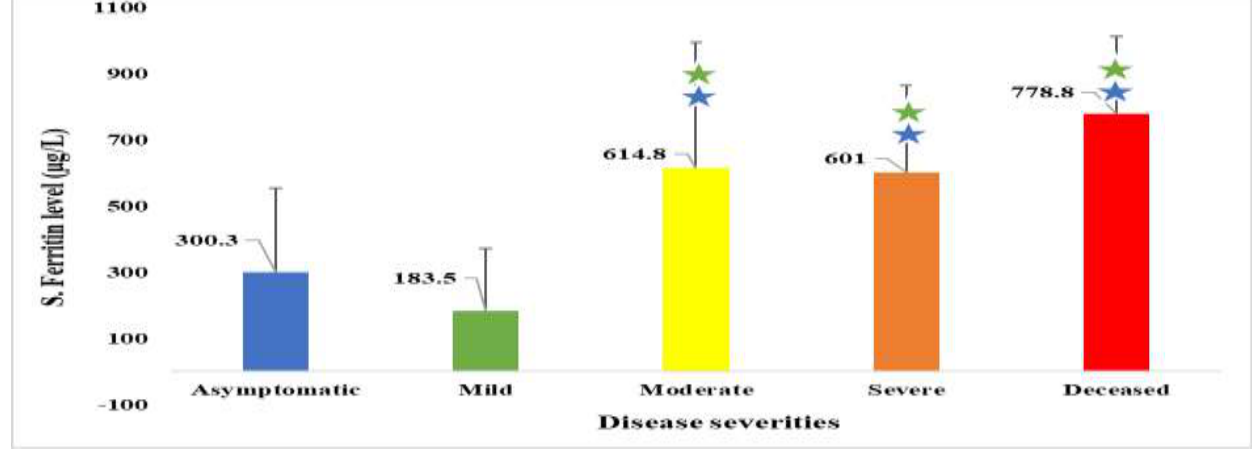
Figure 9: Ferritin levels in 100 patients with COVID-19 of different severities.